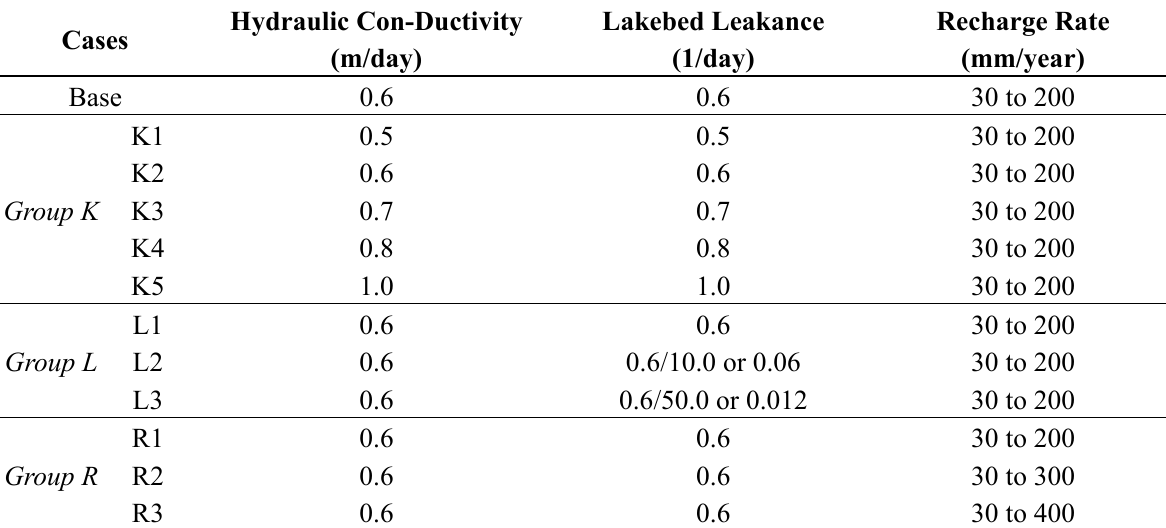
Table 2. Summary of the parameter settings for the numerical experiments.